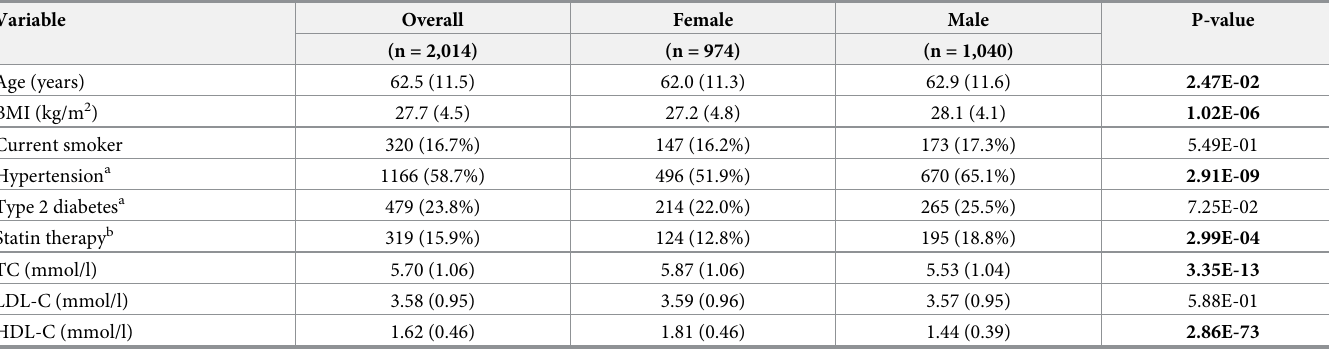
Table 1. Basic sample